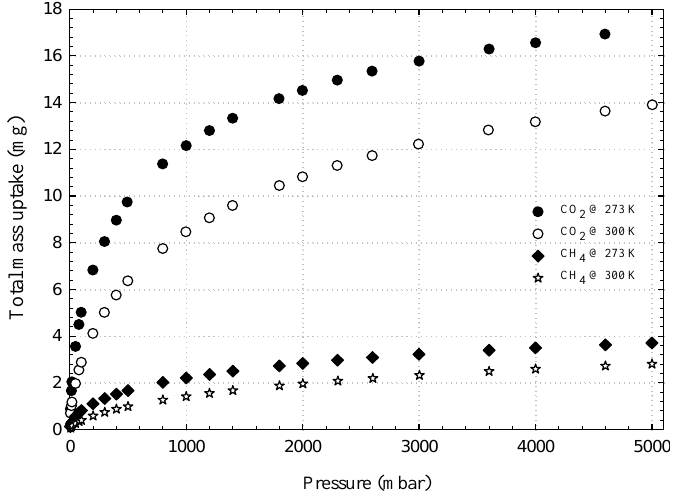
and semi-log ( b ) scales.